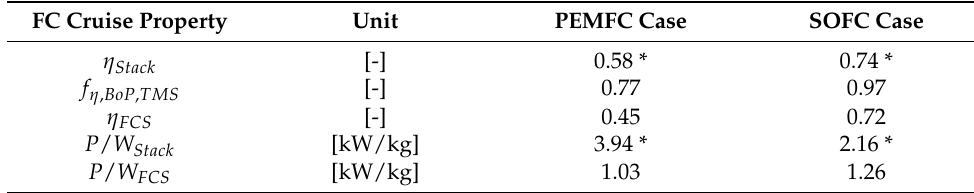
Table 6. Cruise efficiency and specific power characteristics calculated for selected PEMFC and SOFC technology